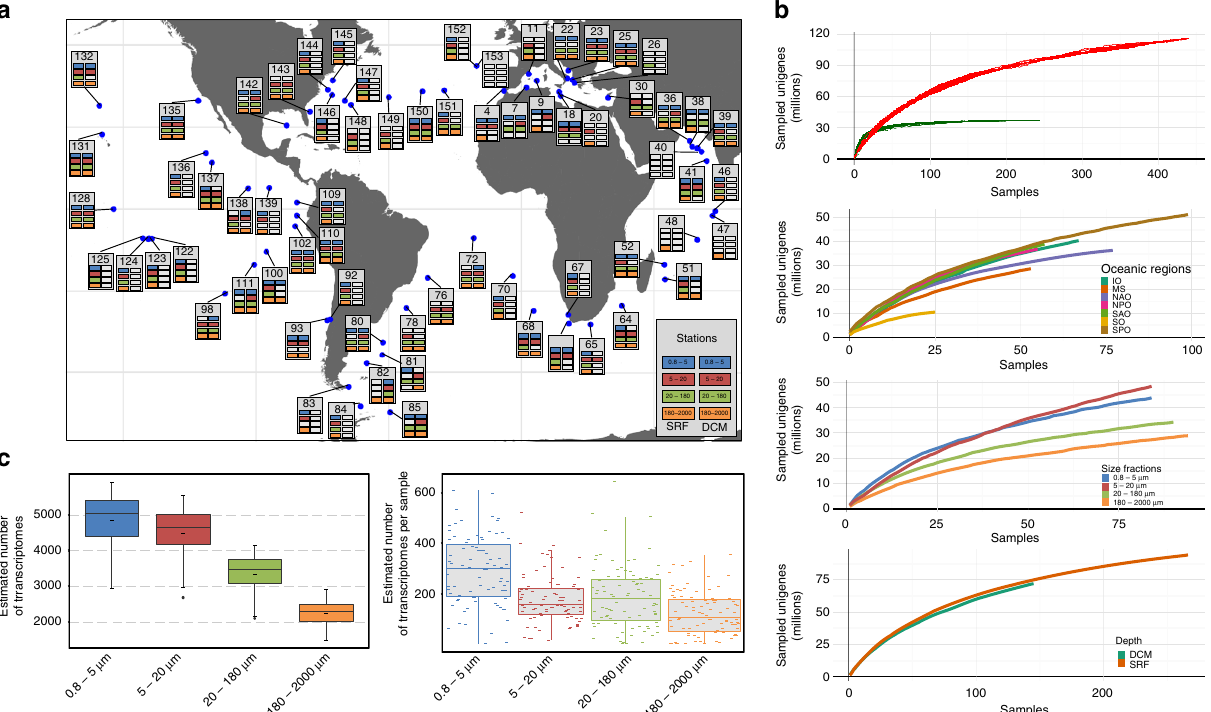
Fig. 1 The Tara Oceans eukaryote gene catalog. a Sampling map. Geographic distribution of 68 sampling stations at which seawater from the surface (SRF) and/or the deep chlorophyll maximum (DCM) was collected and size fractionated into four main groups: 0.8 – 5 µ m (blue), 5 – 20 µ m (red), 20 – 180 µ m (green), and 180 – 2000 µ m (orange). Availability of sequence data sets is indicated by the colored boxes at each sampling station. Two stations (TARA_40 and TARA_153) containing only atypical size fractions are shown on this map with empty boxes. b Rarefaction curves of detected genes. Top panel: rarefaction curves of 441 eukaryotic samples (red curve) compared to 139 prokaryotic samples (green curve) derived from Sunagawa et al 9 . Other panels: rarefaction curve of eukaryotic samples by oceanic region (IO, Indian Ocean; MS, Mediterranean Sea; NAO, North Atlantic Ocean; NPO, North Paci fi c Ocean; SAO, South Atlantic Ocean; SO, Southern Ocean; SPO, South Paci fi c Ocean), size fraction, and depth (SRF or DCM). For each curve, sampling order has been 10-fold permuted. c Estimated number of transcriptomes in eukaryotic samples. Left panel: distribution of the total number of transcriptomes estimated for each size fraction computed from the number of unigenes similar to a catalog of 24 single-copy ribosomal proteins. Right panel: